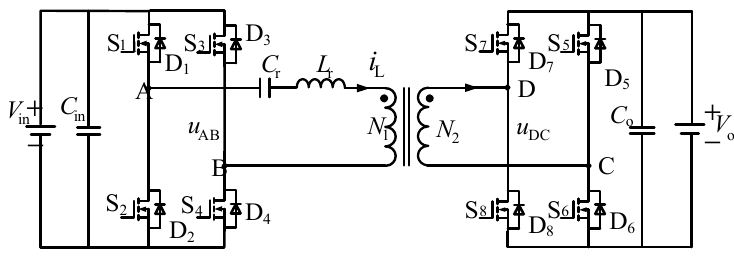
Figure 1. Series-resonant-type dual-active-bridge converter topology. In this paper, phase-shift modulation is adopted, the duty ratio of all switching tubes is 50% and the upper and lower tubes of the same bridge arm are complementary